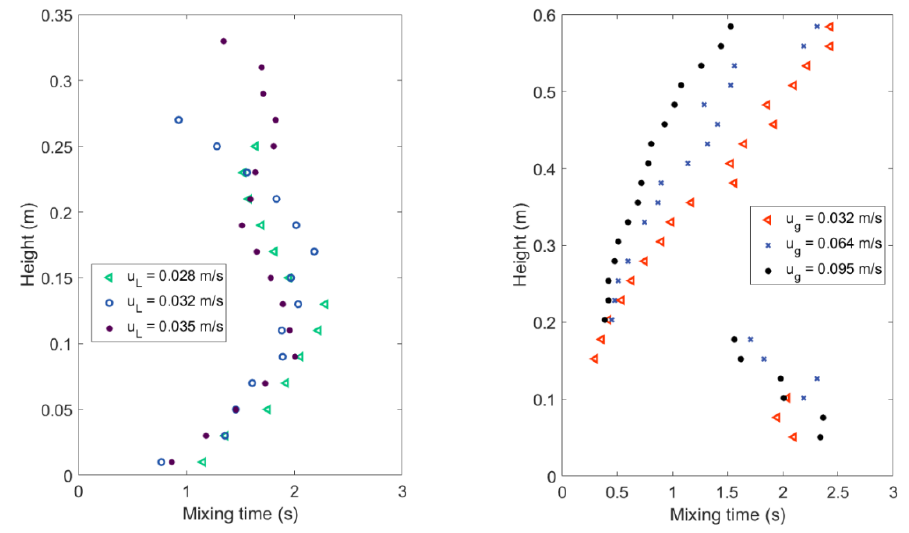
Figure 6 . Axial mixing time profiles for the LSFB ( left ) and the GLSFB ( right ) systems.